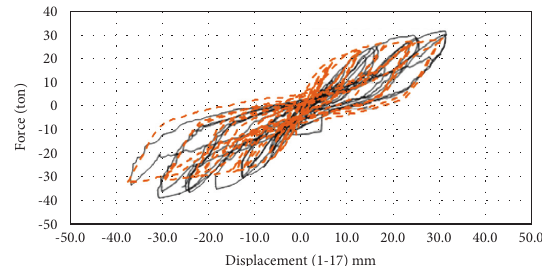
Figure 11: An overview of the laboratory model [22].